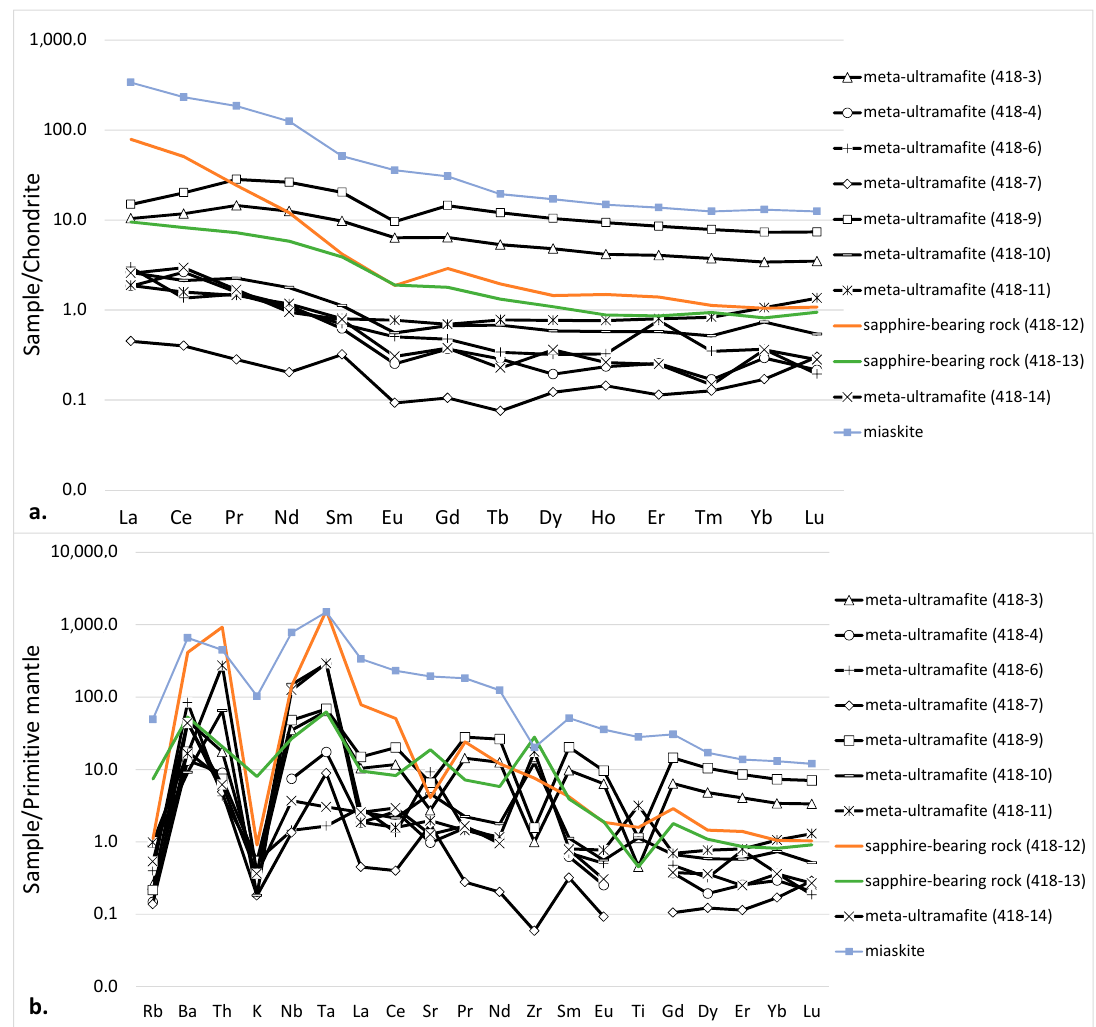
Figure 11. ( a ) Chondrite ‐ normalized REE diagram of selected samples, the chondrite REE data are after [26]; ( b ) Trace elements diagram of selected samples normalized to primitive mantle, data on trace elements in primitive mantle are after [26]. Chemistry of miascite is after [25]